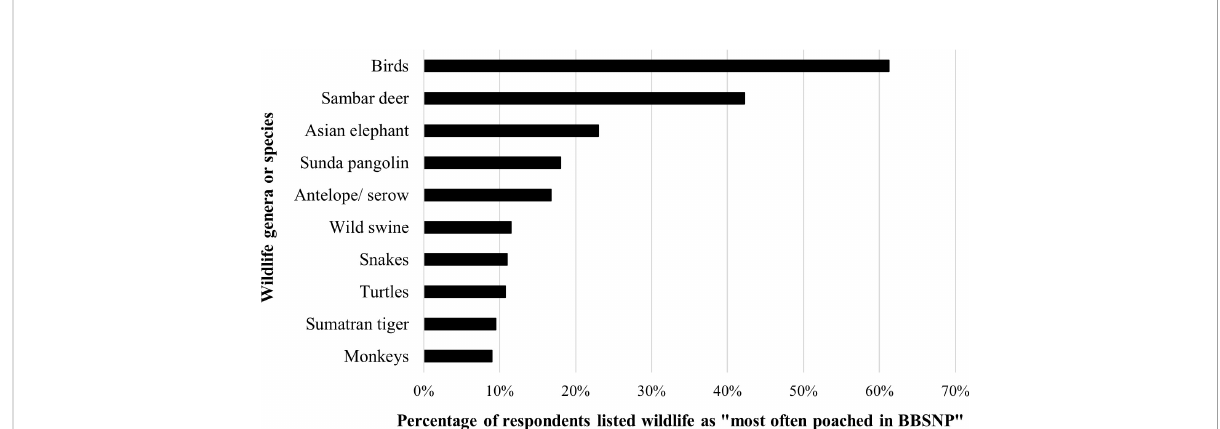
FIGURE 3 Top ten species or genera reported as “ most often poached in Bukit Barisan Selatan National Park by community respondents (N=400) living in and around the Intensive Protection Zone, Sumatra, Indonesia (see S1 for full genera or species list).